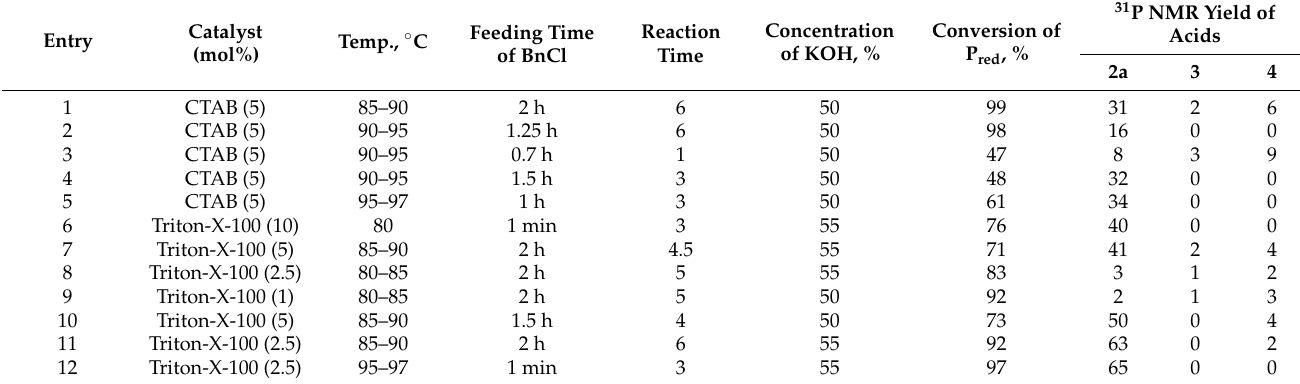
Table 2. Optimization of the reaction parameters (phosphinylation of benzylchloride 1a with red